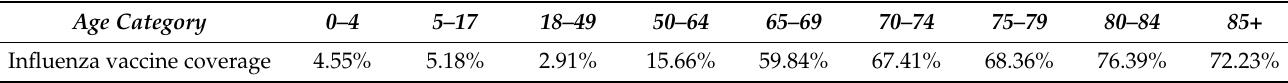
Table 3. Overall vaccine coverage.